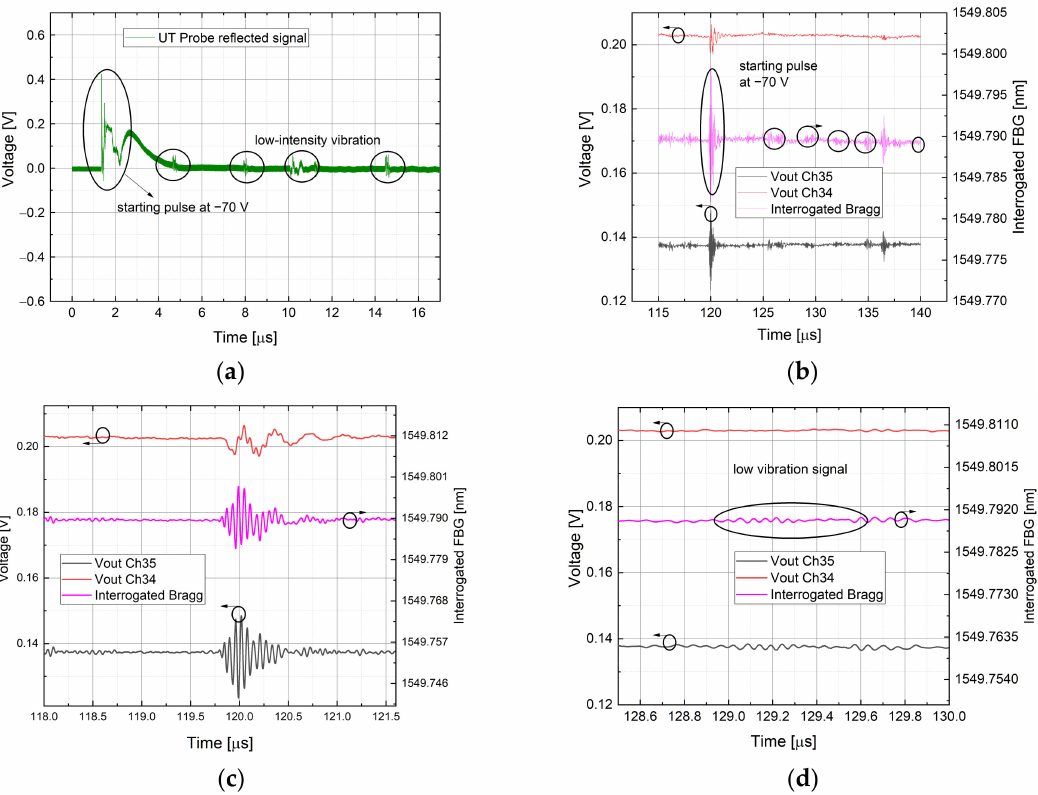
Figure 12. Ultrasound probe reflected signal measurement, with the highlighted part obtained resting the probe on the metal sheet ( a ). Output voltage from the monitoring of channels 35 and 34, with the interrogated FBG in the middle ( b ). Magnified part of the high-speed vibration during the ignition pulse, measured by the FBG sensor ( c ). Magnified about one of the periodic lower intensity vibrations ( d ).